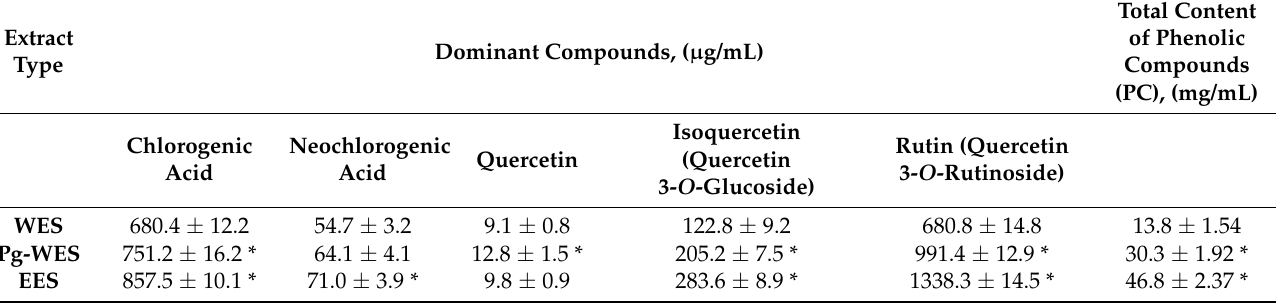
Table 1. The amount of predominant phenolic compounds and the total content of phenolic com- pounds in investigated